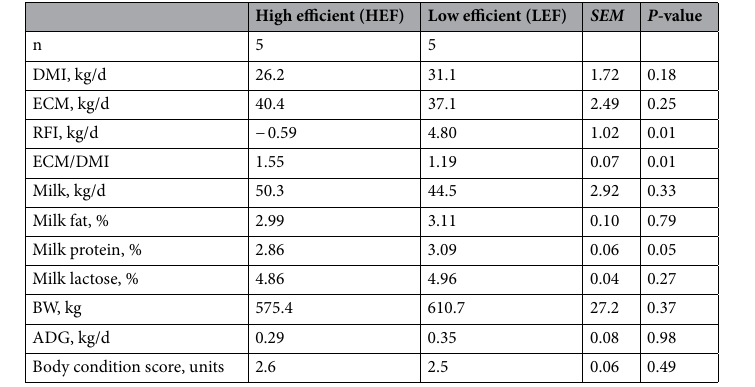
Table 1. DM intake, milk production and efficiency of high and low efficient